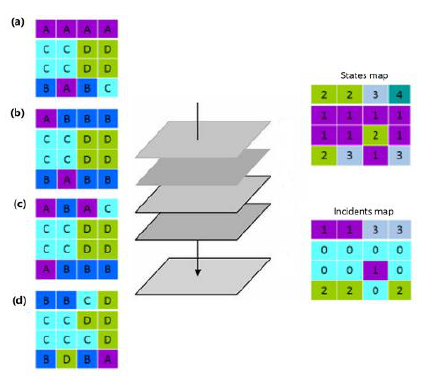
Figure 2. The number of land use the Incidents and the States